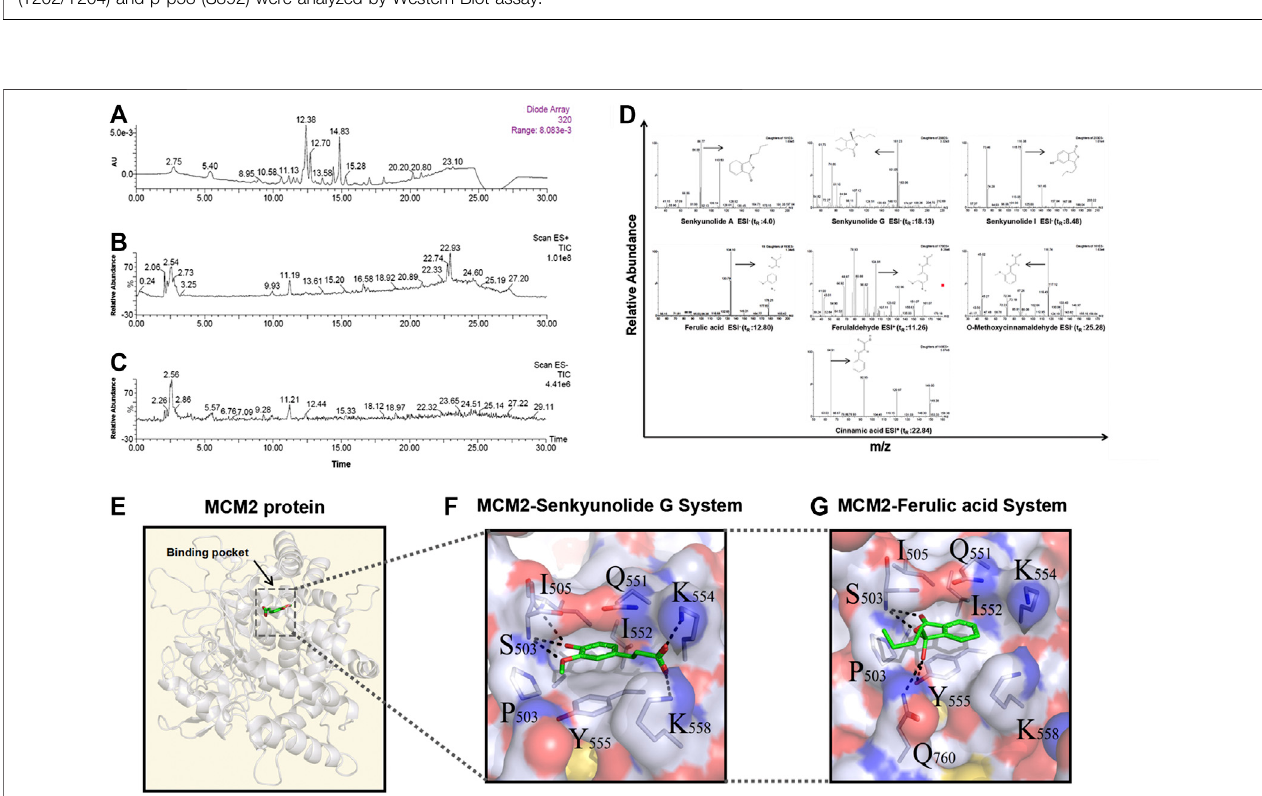
FIGURE 8 | Seven main ingredients obtained from the two monarch drugs (DG and GZ) in DSD by using the LC-MS method and molecular docking analysis by AutoDock. (A) Ultraviolet absorption wavelength map. (B) Total Ion Chromatography (TICs) in positive ion modes. (C) Total Ion Chromatography (TICs) in negative ion